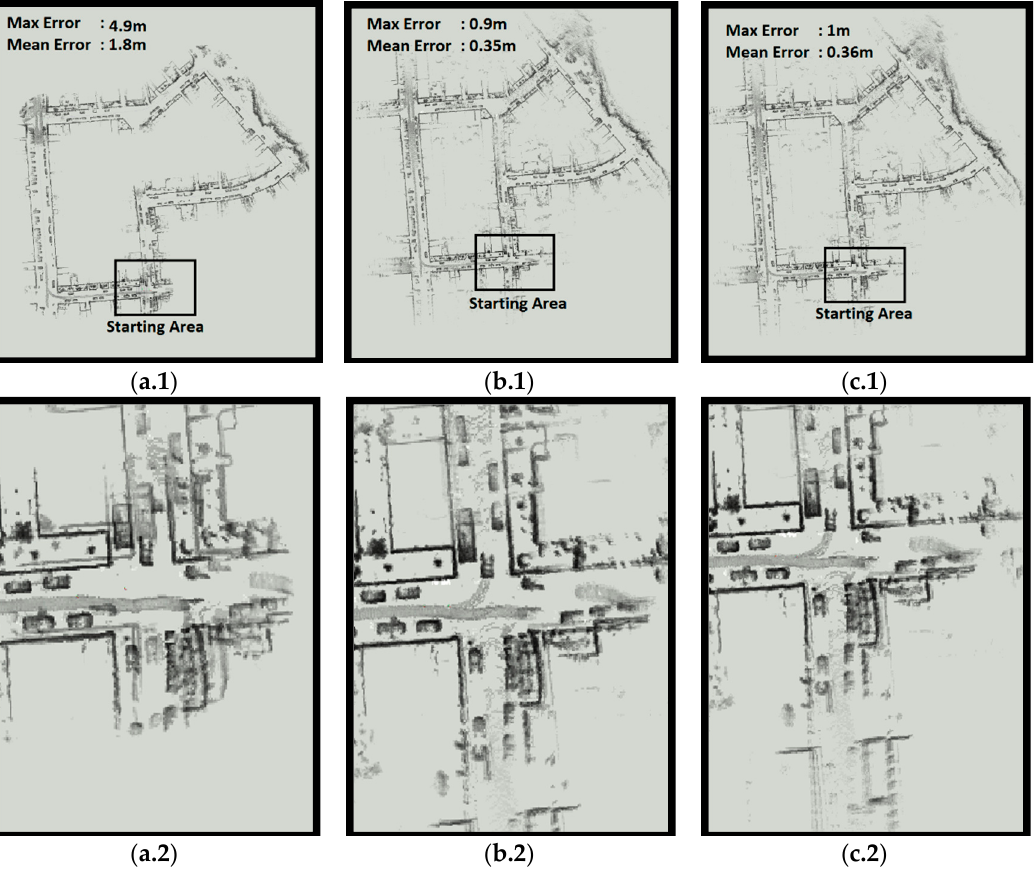
Figure 6. KITTI map results: ( a ) 25 m scan, ( b ) 60 m scan, ( c ) AMDS (60 m/25 m), ( 1 ) full map, and ( 2 ) zoomed starting point.